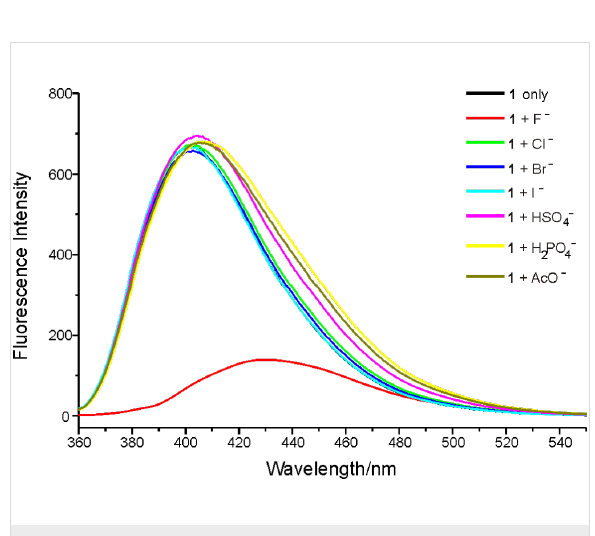
Figure 3: The fluorescence spectra of receptor 1 (5 μ M) in the absence or presence of a 50 equiv of F − , Cl − , Br − , I − , HSO 4 − , H 2 PO 4 − and AcO − anions in CH 3 CN (excited at 340